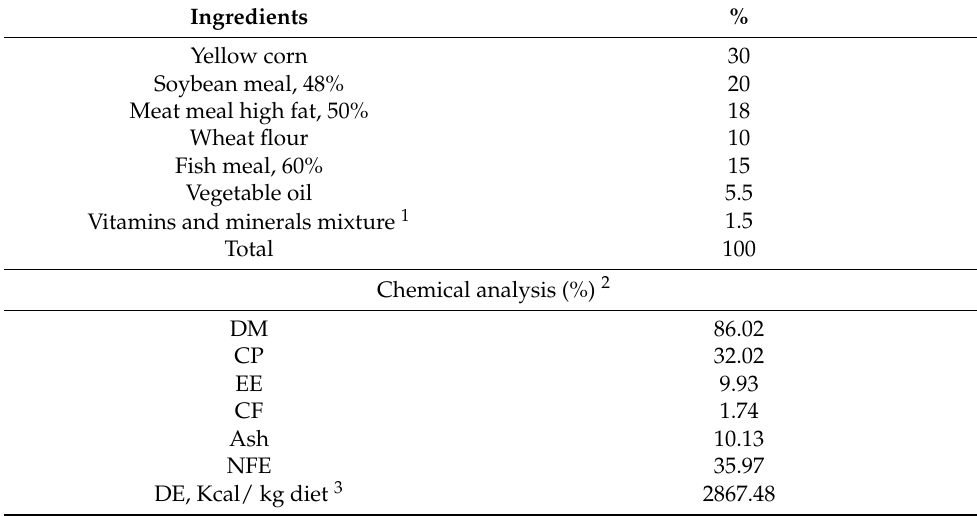
Table 1. Proximate chemical composition of the basal diet (%). Ingredients % Yellow